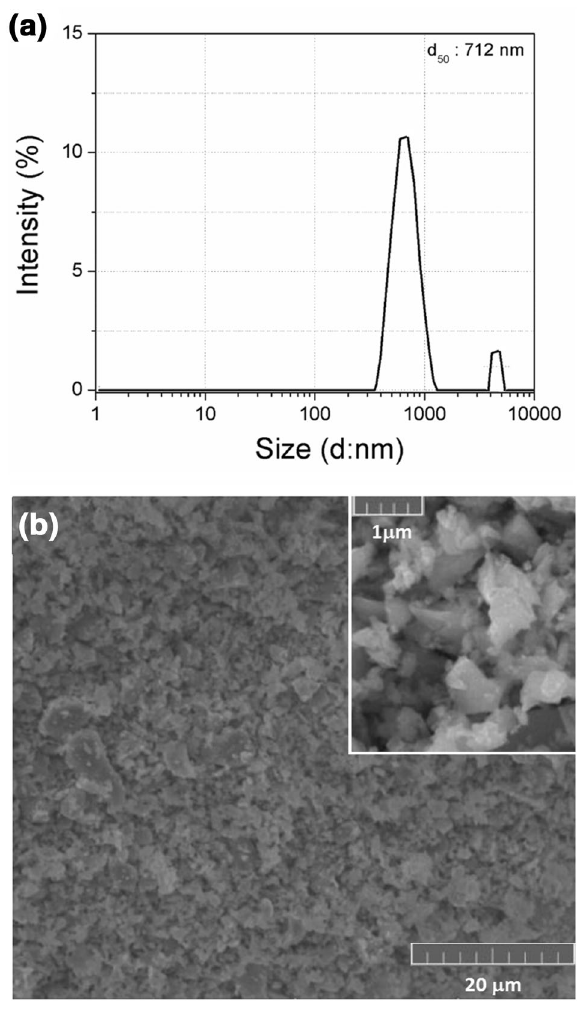
Fig. 2 XRD patterns of the as-prepared La 0.6 Sr 0.4 Co 0.2 Fe 0.8 O 3 elec- trode and after 20 galvanostatic charge/discharge cycles in KOH 6